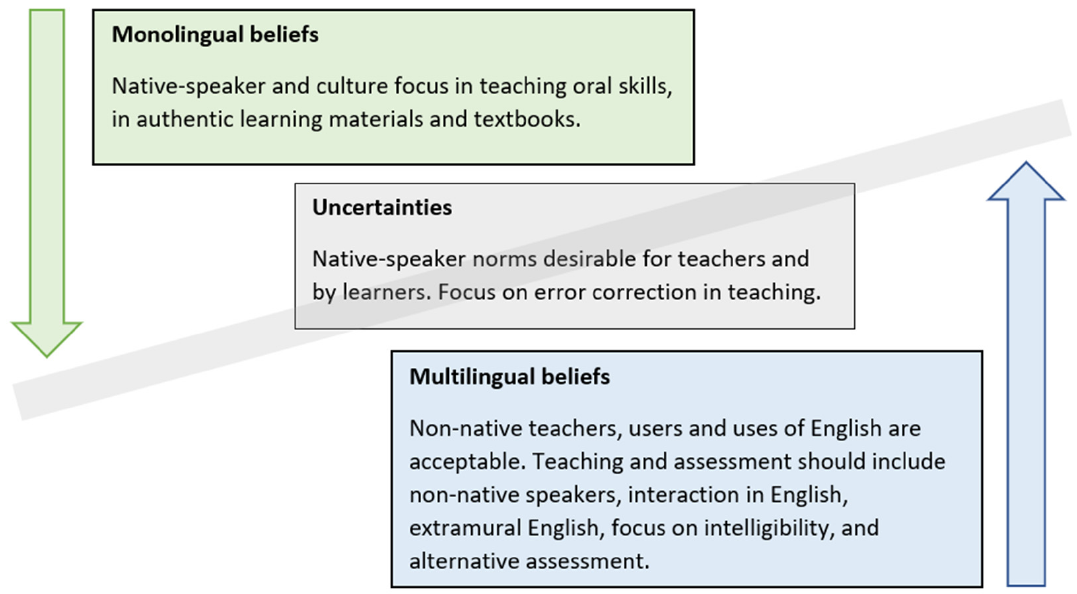
Figure 1. Tensions and uncertainties in English teachers’ language beliefs and reported practices in the Norwegian multilingual context.